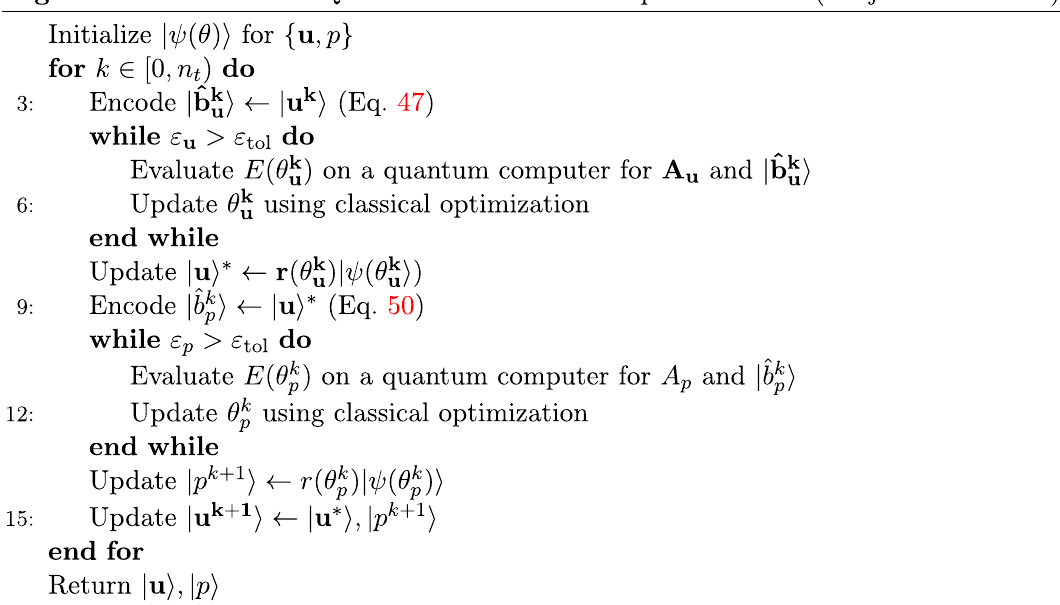
Figure 7. ( a ) 2D lid-driven cavity flow ( Re boundary sliding in the x direction at u ( x , 0 ) velocity quivers in white indicating direction of flow. ( b ) Plots of cumulative number of function evaluations (Nfeval) vs. time for intermediate velocities ( u , v ) and pressure ( p